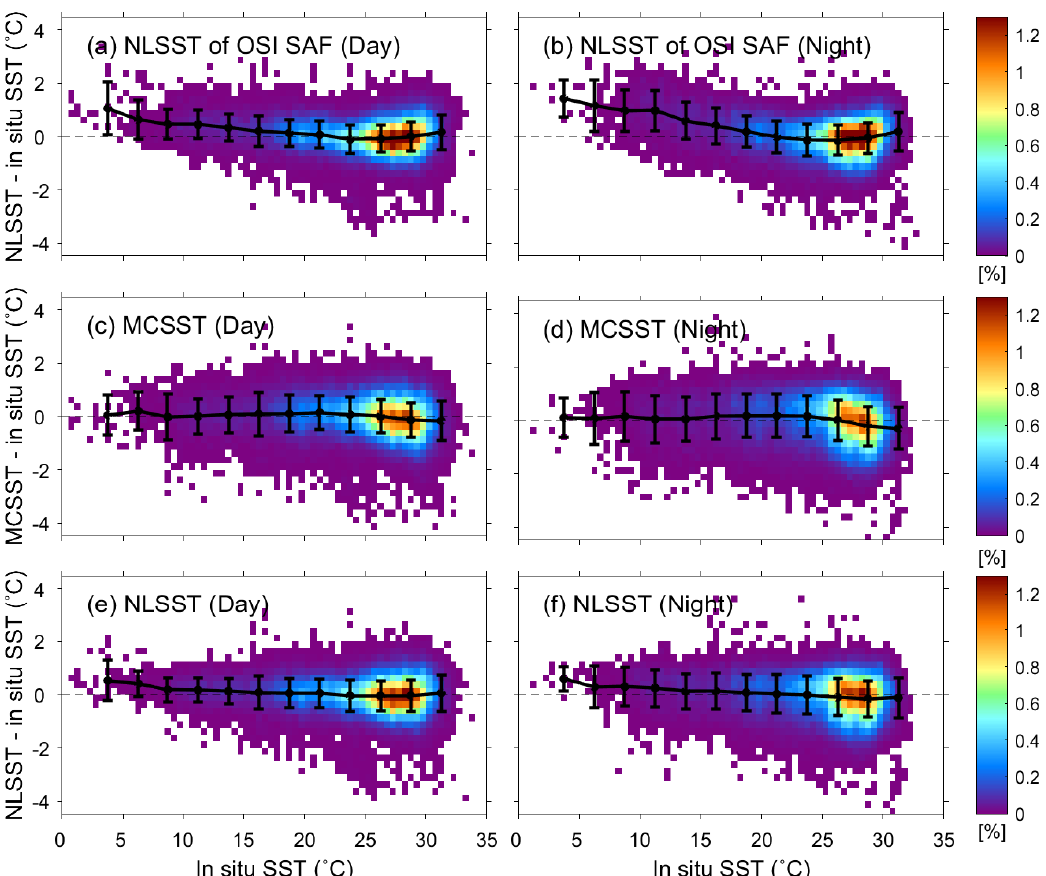
Figure 4. Distributions of NLSST errors of OSI SAF during the ( a ) daytime and ( b ) nighttime, MCSST errors during the ( c ) daytime and ( d ) nighttime, and NLSST errors in the ( e ) daytime and ( f ) nighttime as a function of the in situ SST ( ◦ C). The color represents the percentage of the data to the total number of matchup points in each bin; error bars represent the standard deviation of SST errors of each interval.